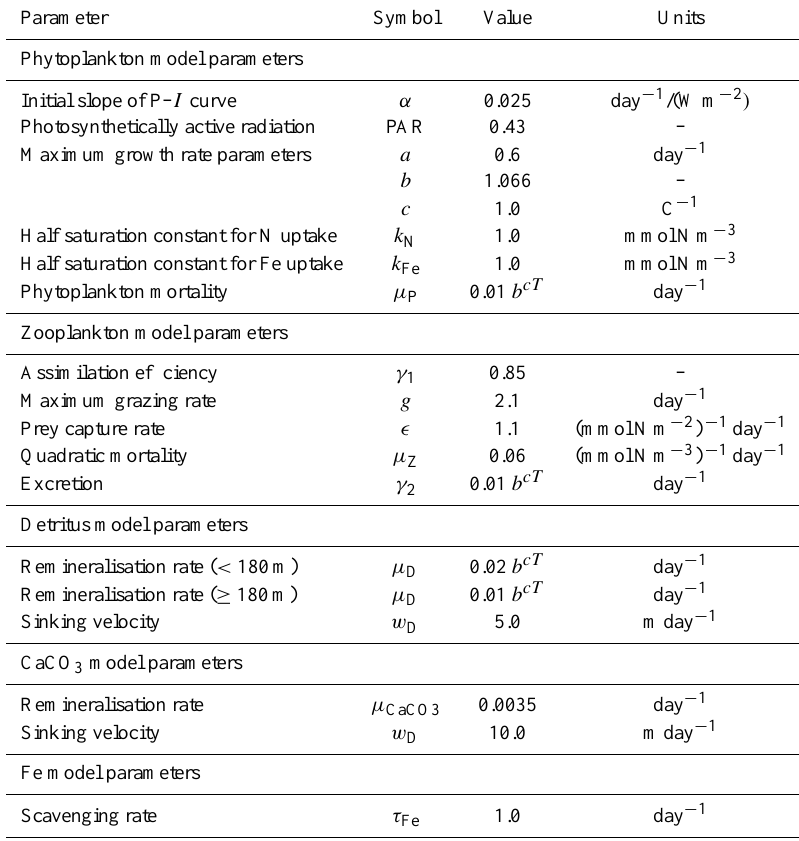
Table B1. Model parameters of the BGC model were set to the values optimised in the 1-D model of the North Atlantic (Schartau and Oschlies,